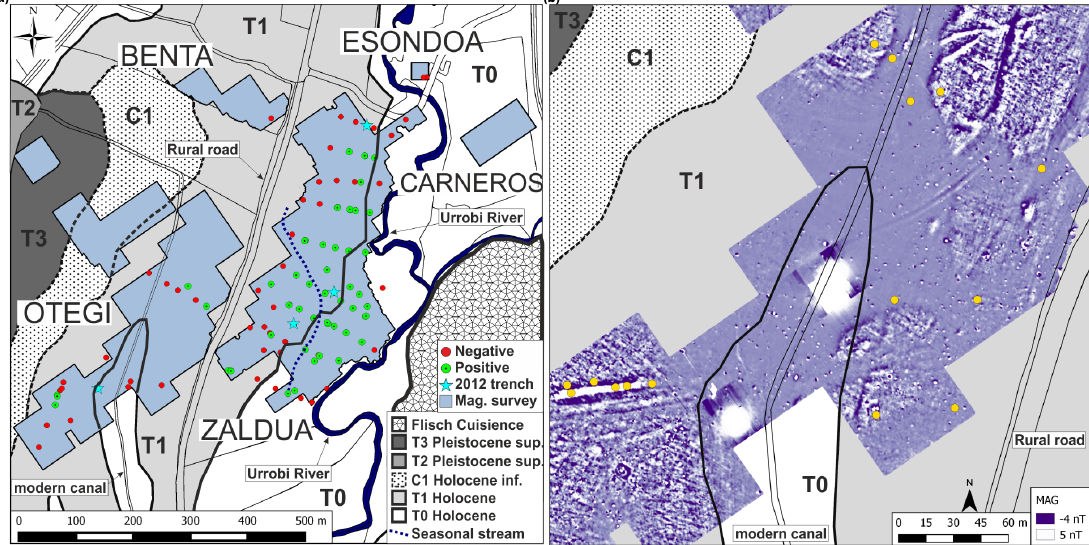
Figure 3. ( a ) Location of the cores drilled in 2014 over the geological plan and areas of the magnetic survey (T: Terrace ; C: Colluvium ). The cores showing archaeological deposits are highlighted as positives, and the ones where no archaeological remains were identifies as negatives. ( b ) Location of the cores drilled in Otegi area in 2016, over the magnetic response